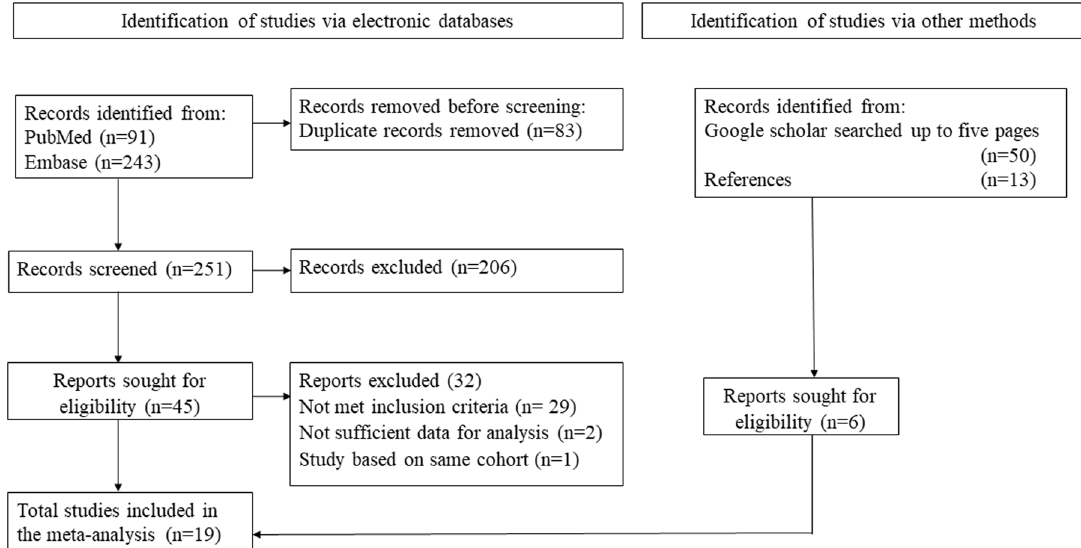
Fig. 1 The selection process of studies for meta-analysis. PRISMA fl owchart. PRISMA Preferred reporting items for systematic reviews and